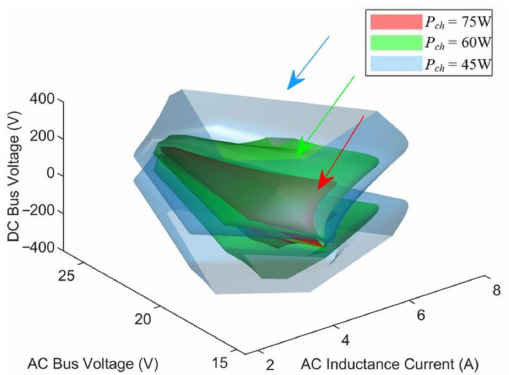
Figure 24. Different 3D RAS of microgrids when battery charging powers are 45 W, 60 W and 75 W.